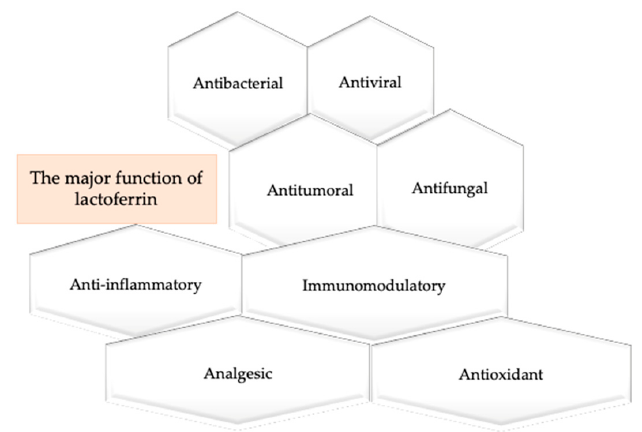
Figure 2. Major functions of lactoferrin.